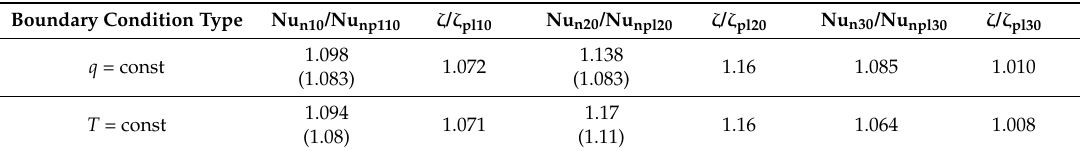
Table 2. Thermal and hydraulic performance of three sections of the narrow channel with a spherical dimple at different boundary conditions q = const and T = const.